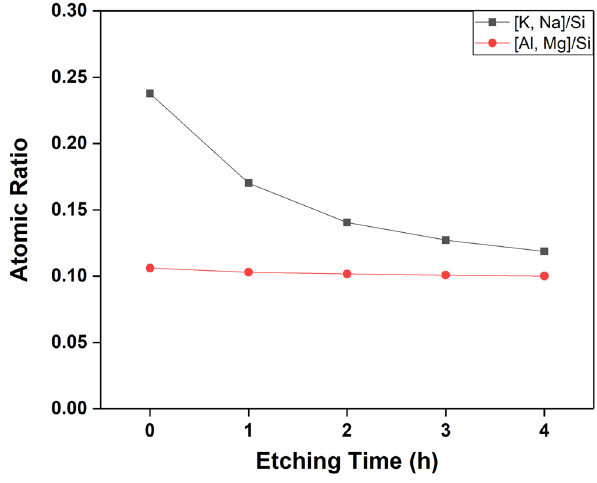
Figure 3: Atomic ratio [ cationic/Si ] changes with etching time of CSG.